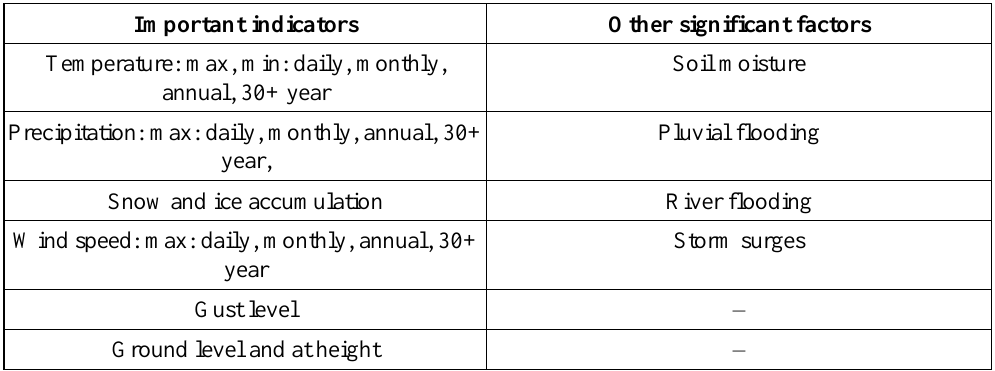
Table 1. The relevant meteorological and climatologic factors for industrial real estate location development planning [developed by authors] Important indicators Other significant